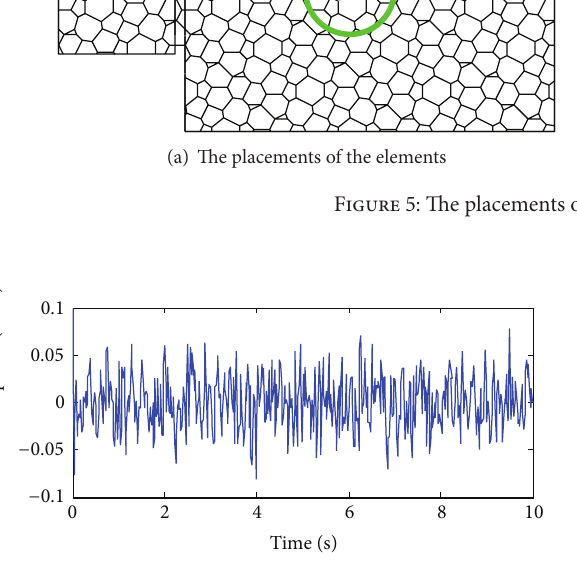
Figure 6: The acceleration time series in 𝑋 direction of the first load case.